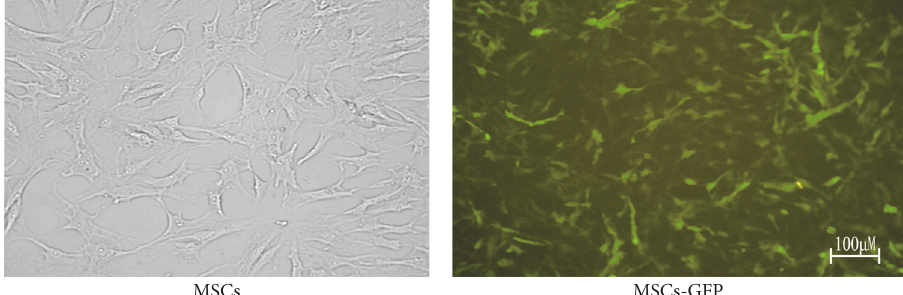
Figure 1: MSCs carrying GFP were determined by fluorescence microscopy. The transfection efficiency was over 80%.